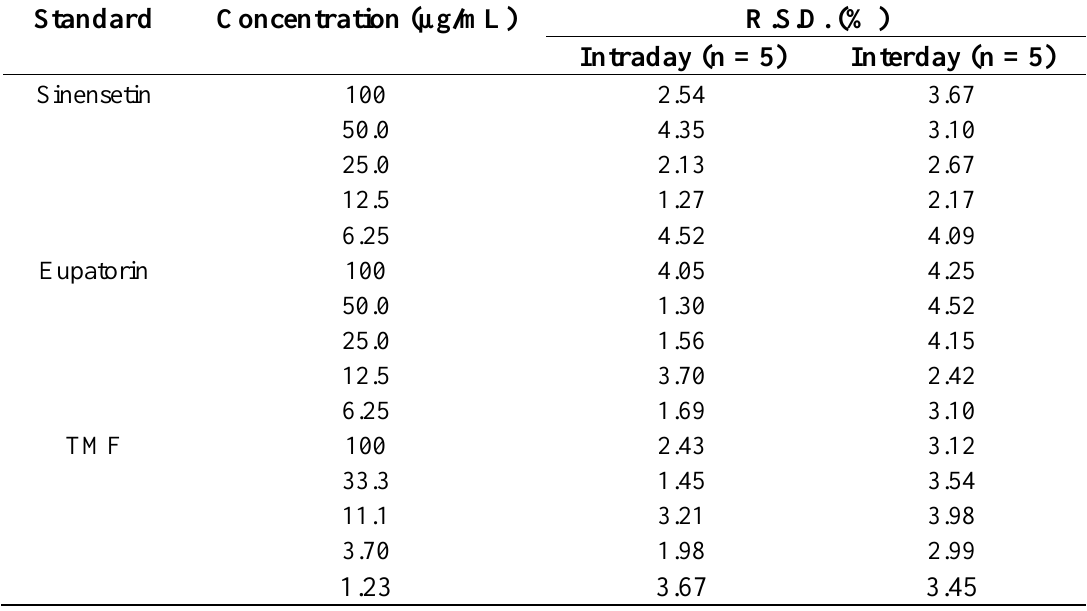
Table 2. Intra-day and inter-day precision for determination of sinensetin, eupatorin and TMF.